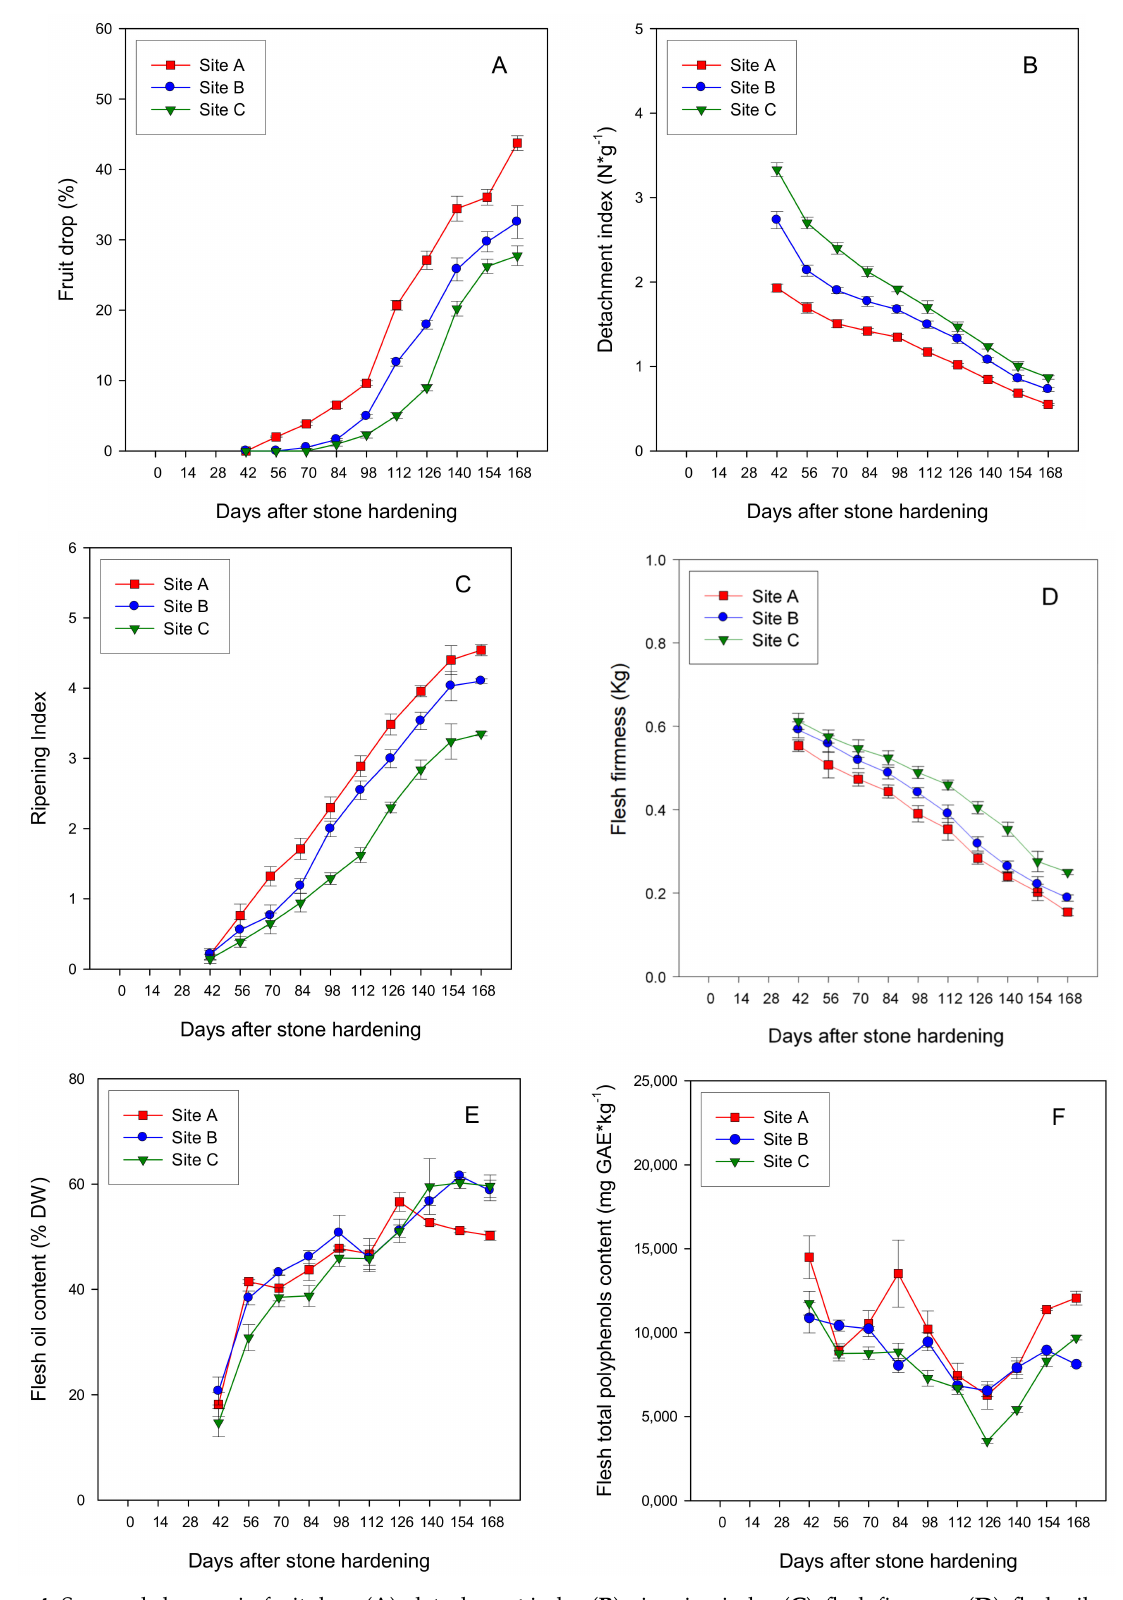
Figure 4. Seasonal changes in fruit drop ( A ), detachment index ( B ), ripening index ( C ). flesh firmness ( D ), flesh oil content ( E ) and flesh total polyphenols content ( F ) in drupes of “Carolea” trees grown at three different sites. Data are mean ± standard error (years 2013, 2014 and